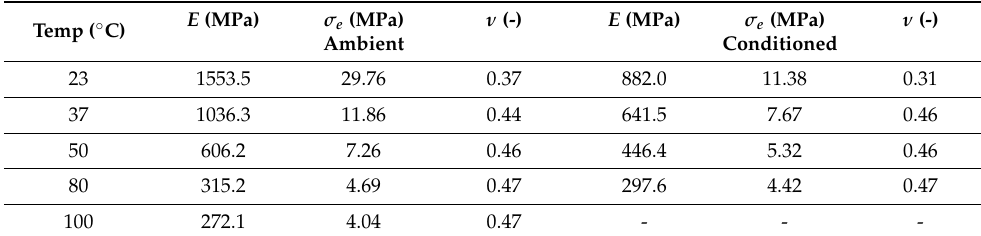
Table 1. Linear elastic values. E and ν were taken from [18]. σ e represents the first value of the HC.